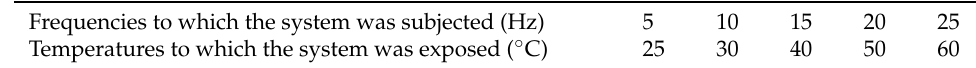
Table 1. The frequency and temperature ranges to which laminated MFC piezoelectric transducers were subjected.